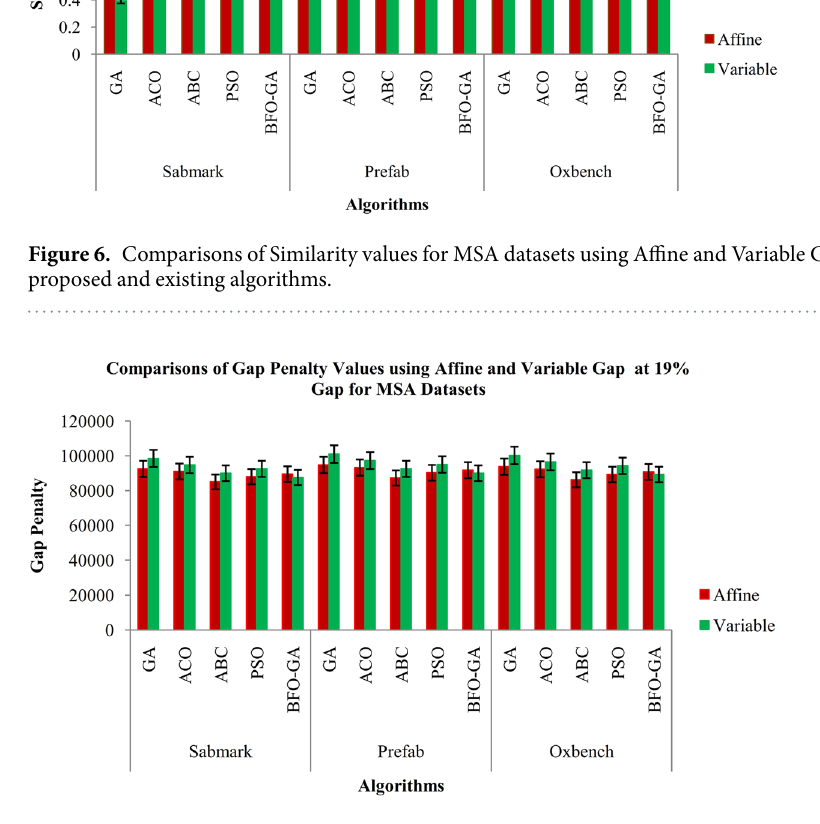
Figure 7. Comparisons of Affine and Variable Gap Penalty values for MSA Datasets using the proposed and existing algorithms.